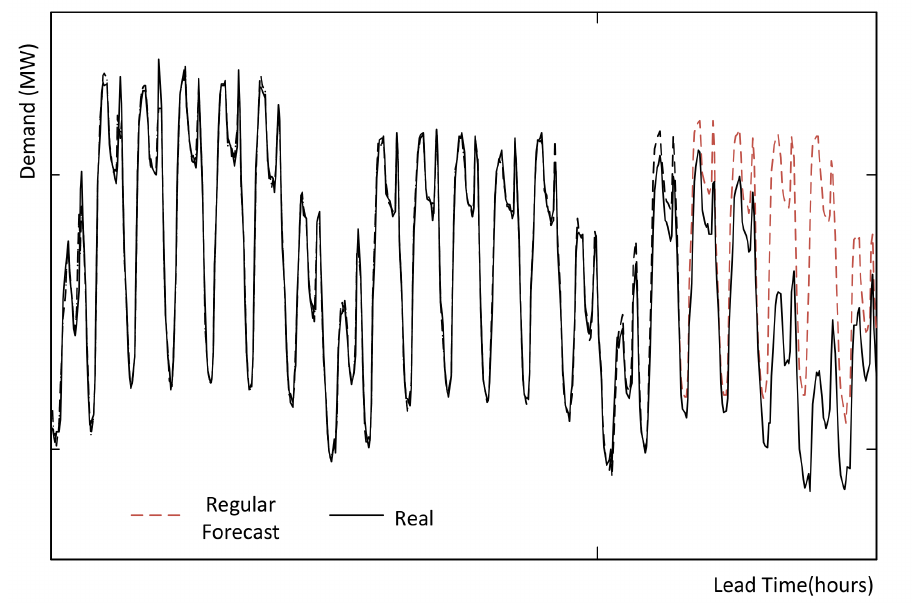
Figure 1. Comparison of the effect produced by a special event (Easter in this case) on the hourly time series of electricity demand in